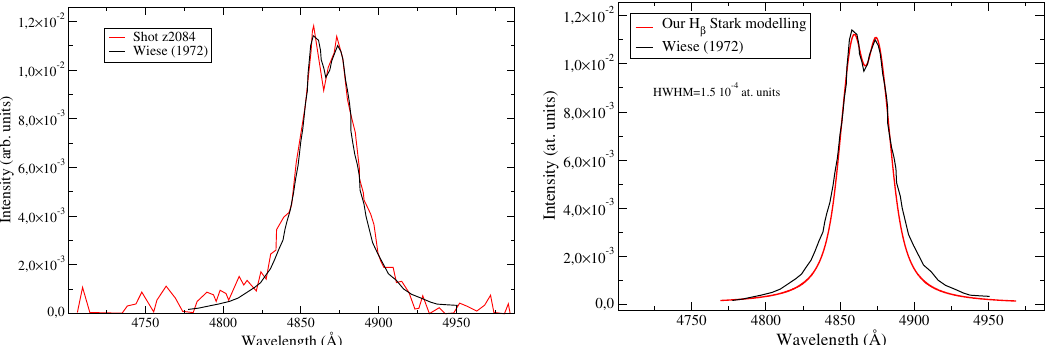
Figure 24. Left : comparison between the H β profile measured by Wiese at T = 1.15 eV and n e = 8.3 × 10 16 cm − 3 and the experimental result obtained at SNL at n e = 5.76 × 10 16 cm − 3 and proton density n H = 1.55 × 10 17 cm − 3 (Shot z2084). Right : calculation with our line-shape code (the electric field is chosen equal to 2 × 10 − 5 atomic units and the profile is convolved with a Lorentzian of HWHM = 1.5 × 10 − 4 atomic units. The spectrum of Wiese is also